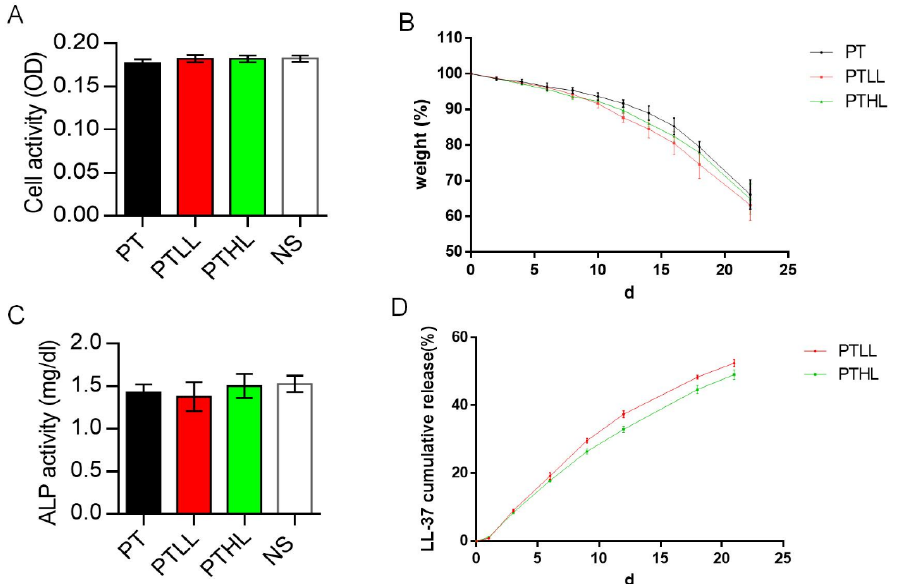
Figure 2. Biocompatibility, degradation rate, osteo-inductivity and controlled release of the PTL scaffold in vitro. ( A ) The cell proliferation of MC3T3-E1 cells on scaffolds measured by CCK-8 kit ( n = 5). ( B ) Degradation rate of PT, PTLL and PTHL scaffolds ( n = 3). ( C ) ALP activity of MC3T3-E1 cells in PT, PTHL PTLL scaffolds and control group after induction for 14 days ( n = 3). ( D ) Accumulated release of LL-37 in vitro ( n = 3).